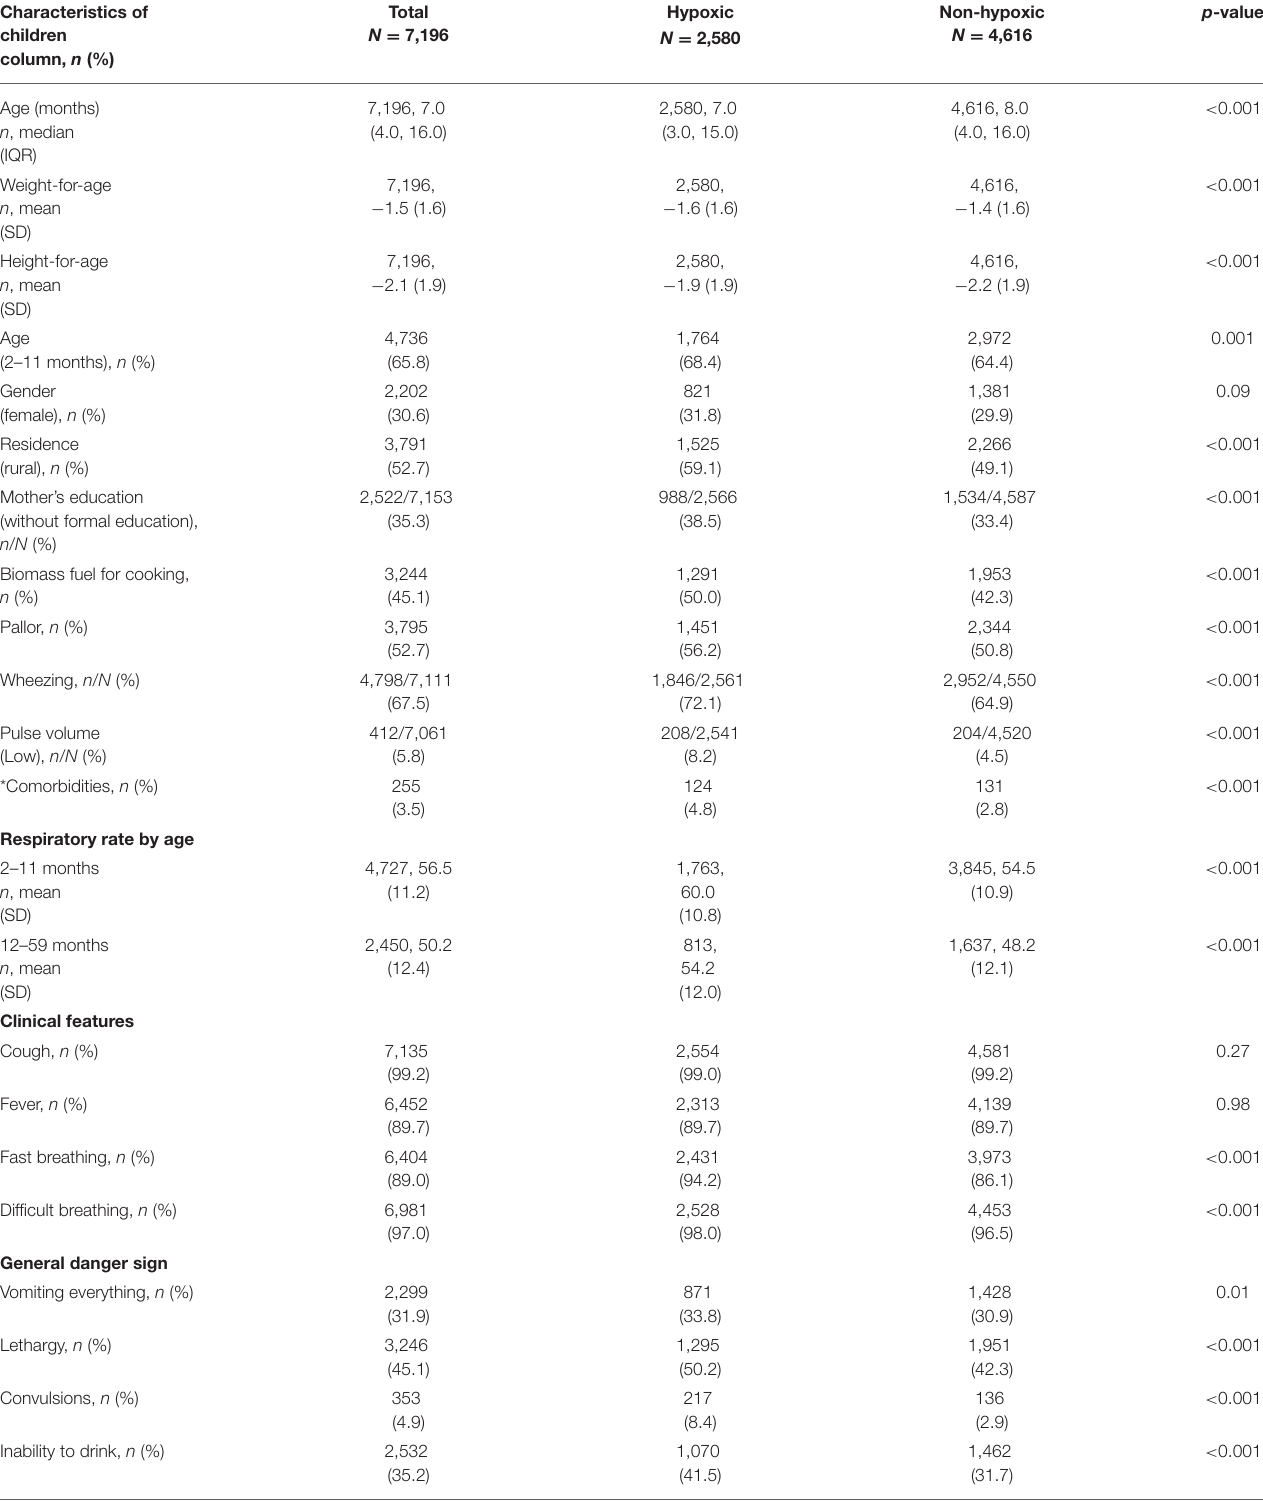
TABLE 1 | Univariate association of clinical variables in cases with hypoxic community-acquired pneumonia. Characteristics of